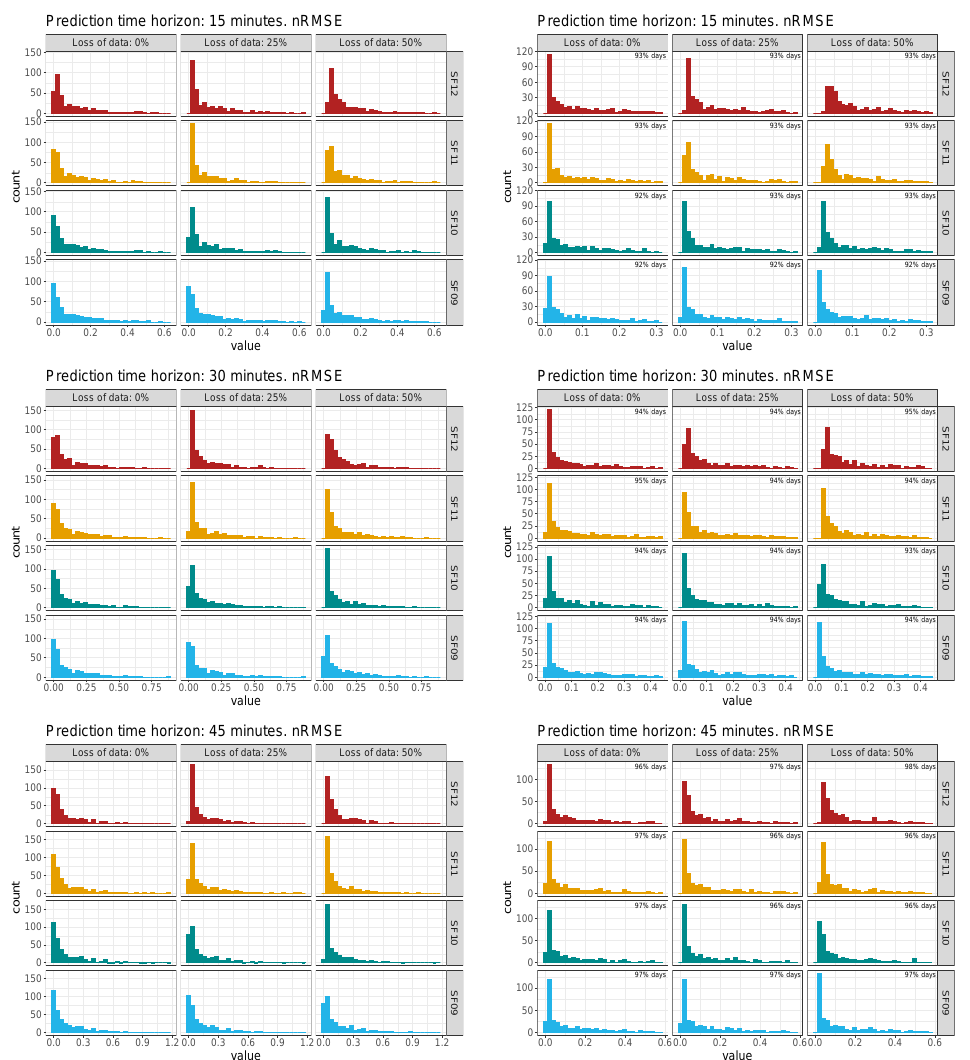
Figure 13. Summary of discrepancies for forecasting and monitoring data based on nRMSE. His- togram ( left ) and truncated histogram ( right